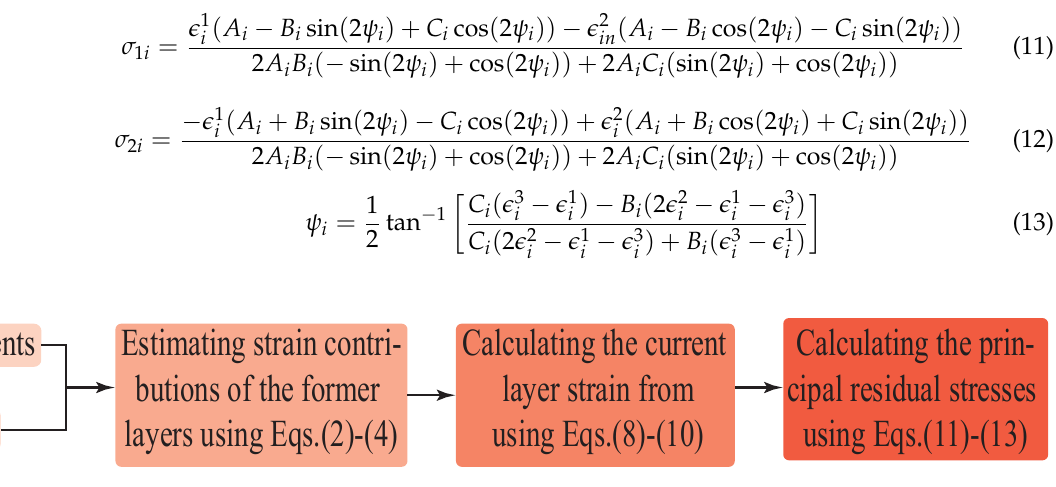
Figure 2. Flowchart of HDM’s analytical